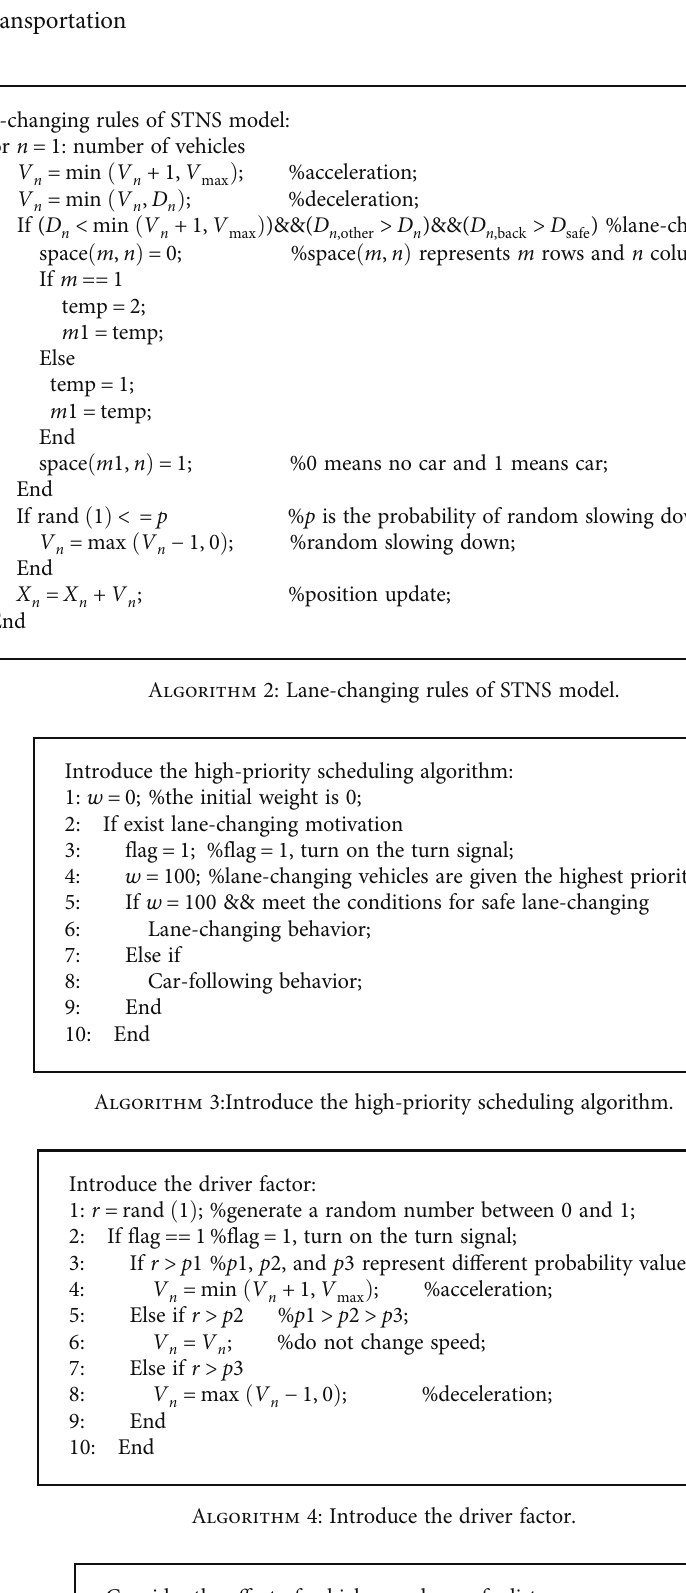
Algorithm 5: Consider the e ff ect of vehicle speed on safe